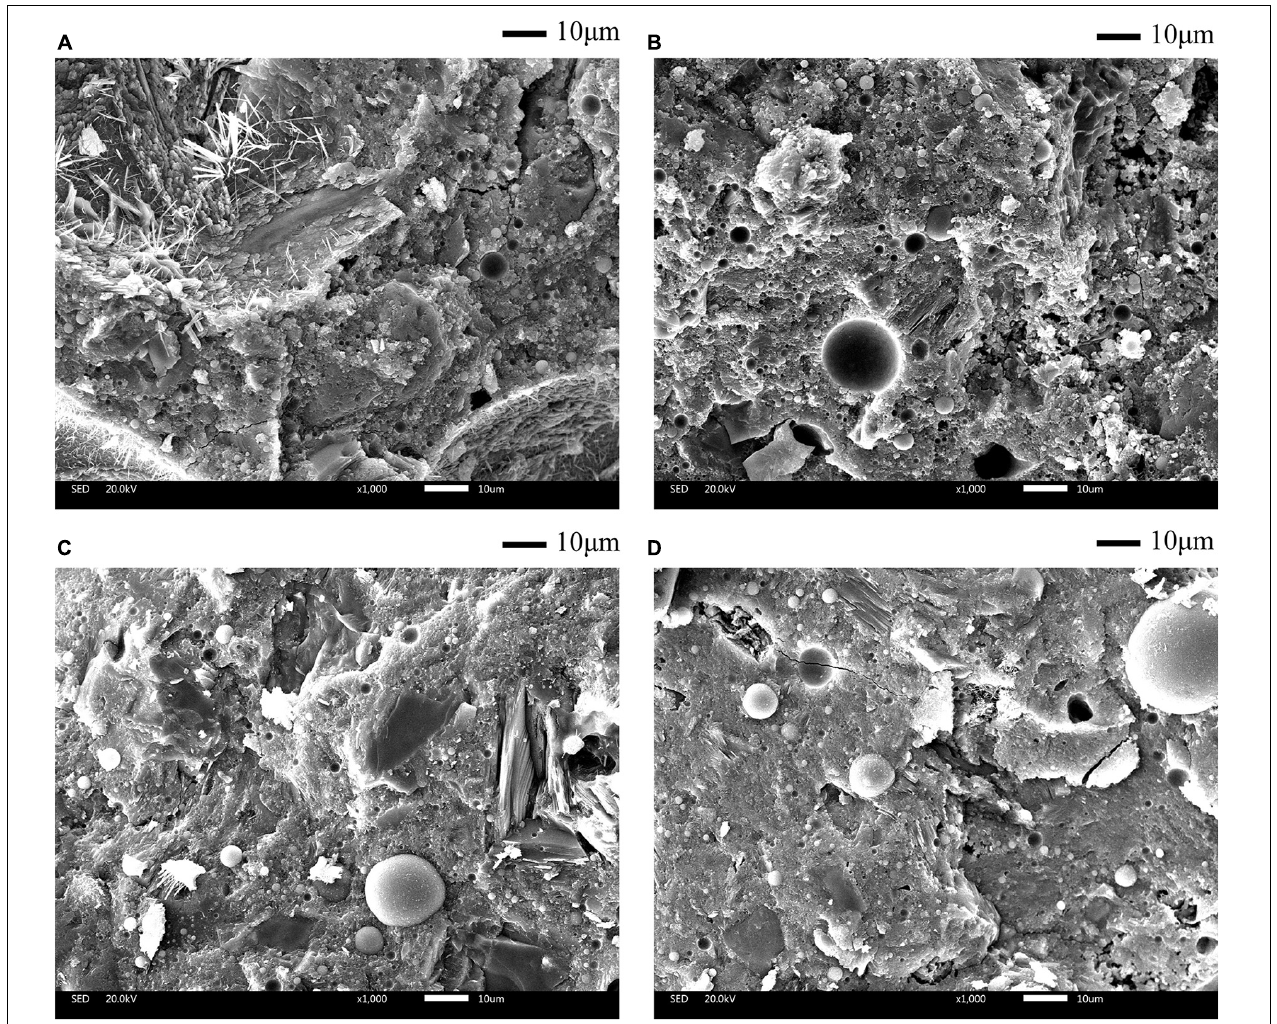
FIGURE 13 | Scanning electron microscopy of 3DPC: (A) NC0 at 7 days, (B) NC4 at 7 days, (C) NC0 at 90 days, (D) NC4 at 90 days.